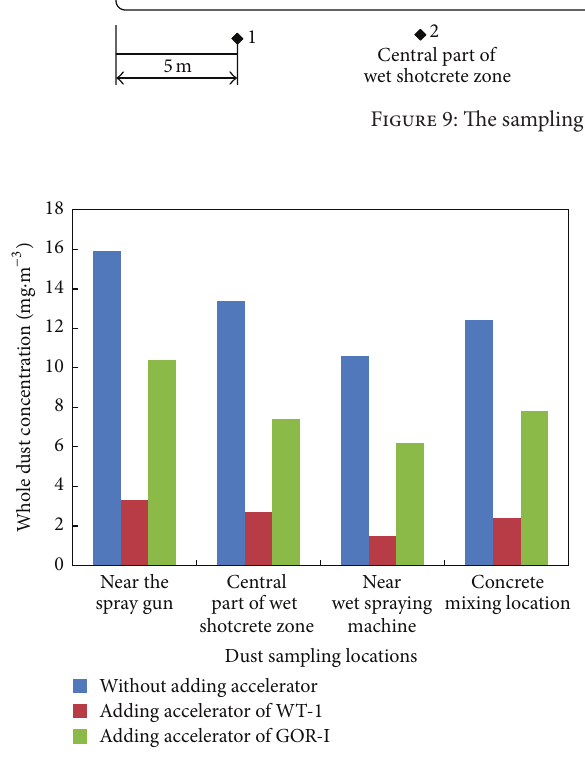
Figure 10: Comparison chart of whole dust concentration.